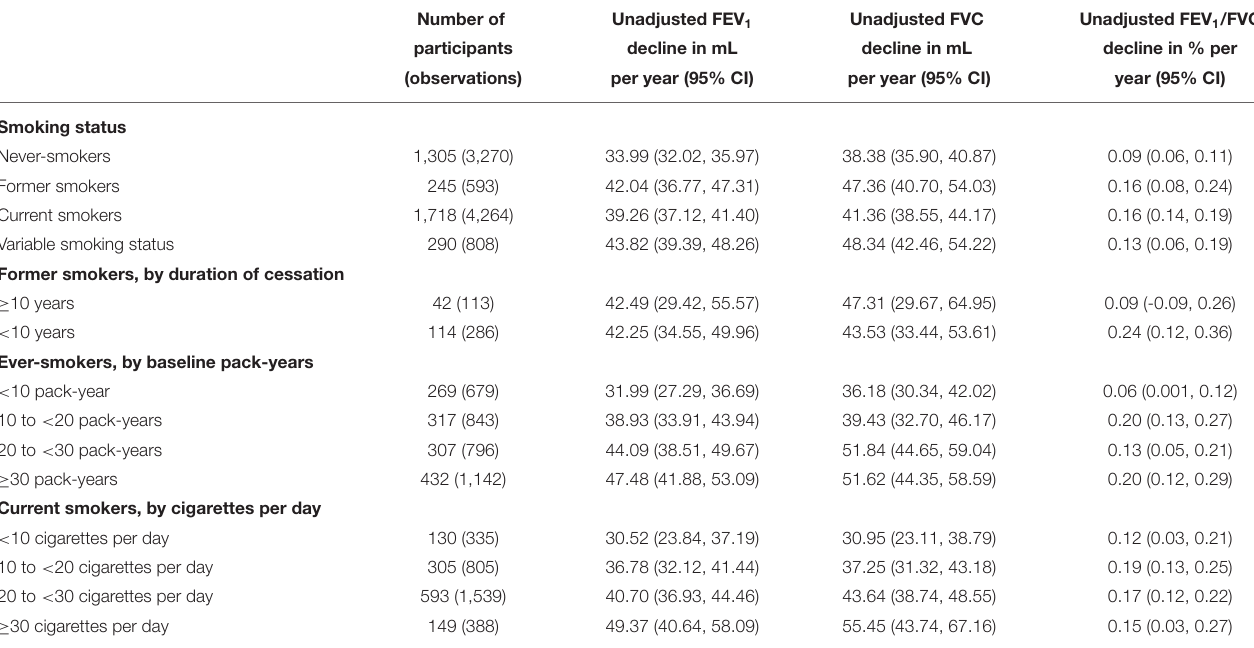
TABLE 3 | Association between smoking status, duration of smoking cessation, cumulative and current cigarette consumption, and lung function decline in the longitudinal